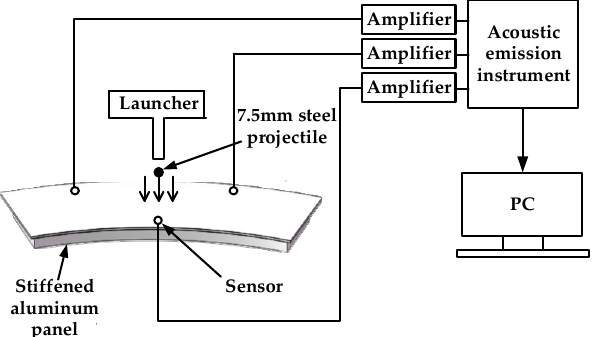
Figure 11. The schematic diagram of the experimental system.